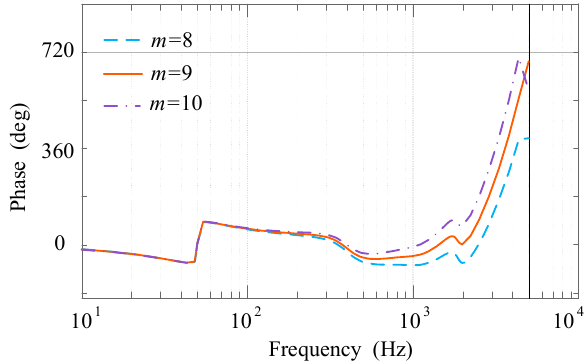
Figure 8. Phase frequency characteristic of z m S ( z ) P ( z ) . when k r changes from 0.2 to 0.8.